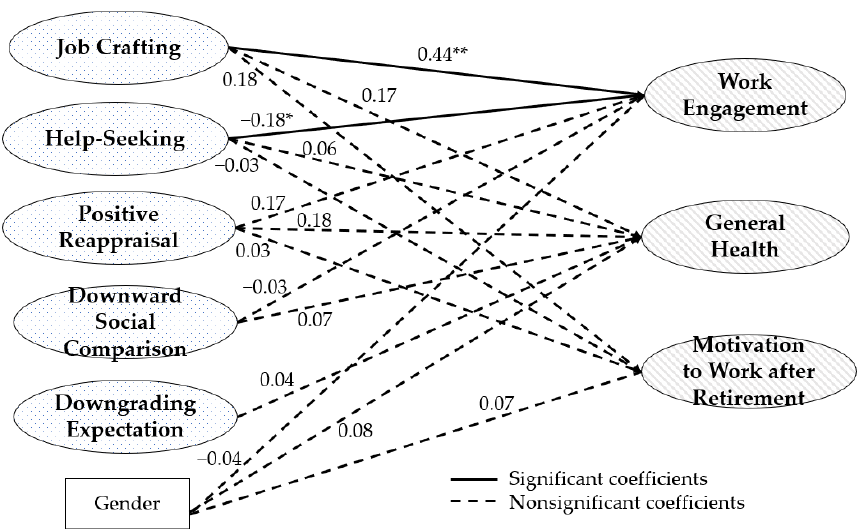
Figure 1. SEM path analysis results for middle-aged group. * p < 0.05; *** p < 0.001.